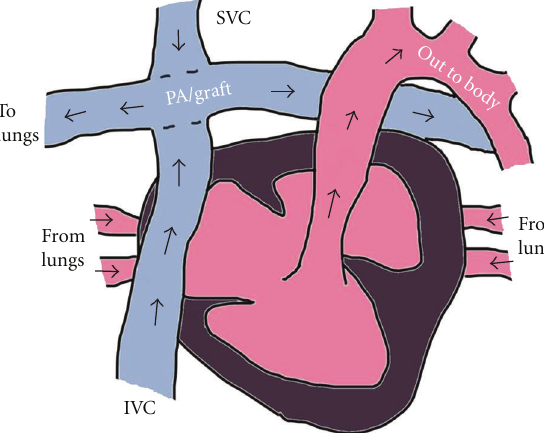
Figure 2: Simplified schematic depicting extracardiac Fontan phys- iology in HLHS. Deoxygenated blood is directly shunted to the lungs via graft to pulmonary arteries, then returned to heart via pul- monary veins where oxygenated blood can be pumped to the rest of the